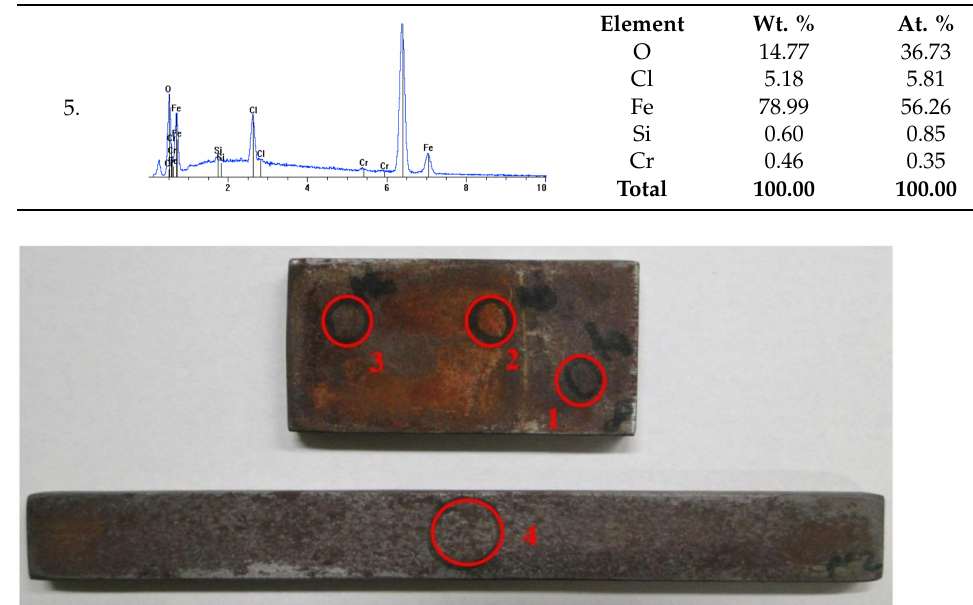
Figure 8. Topography studies of surface in Figure 7, microstructure and chemical composition of the top layer as well as the microstructure of the corroded sample, pressure-conditioned at 80 ◦ C.